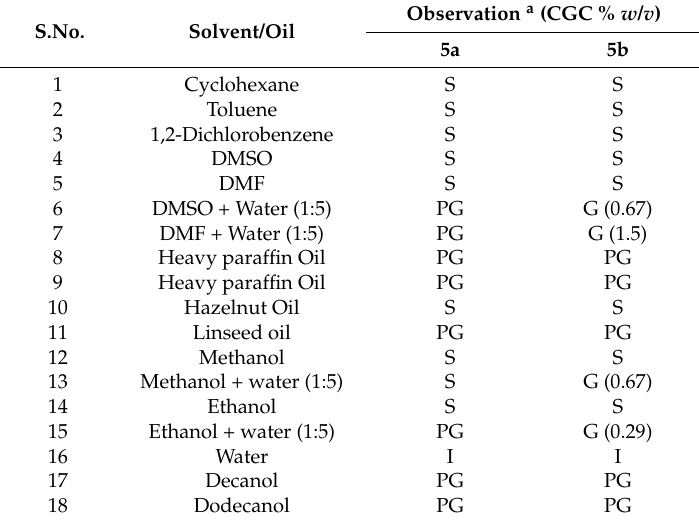
Table 1. Gelation ability of glycolipids, 5a and 5b in various solvents/oil.